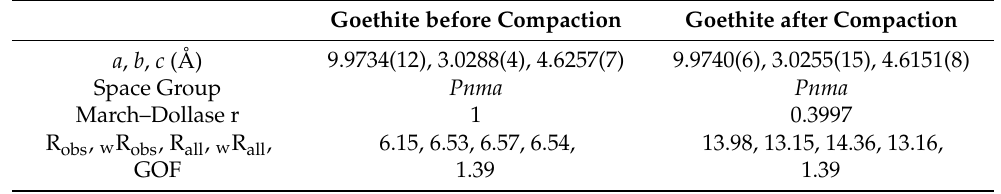
Table 1. Rietveld refinement values (self ‐ polarized material).